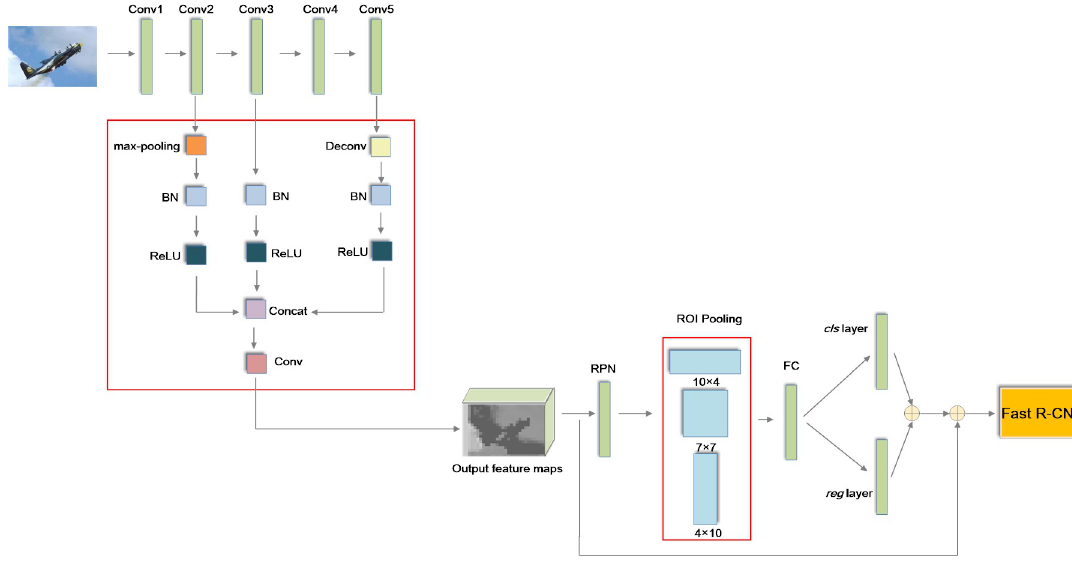
Fig 6. The framework of the